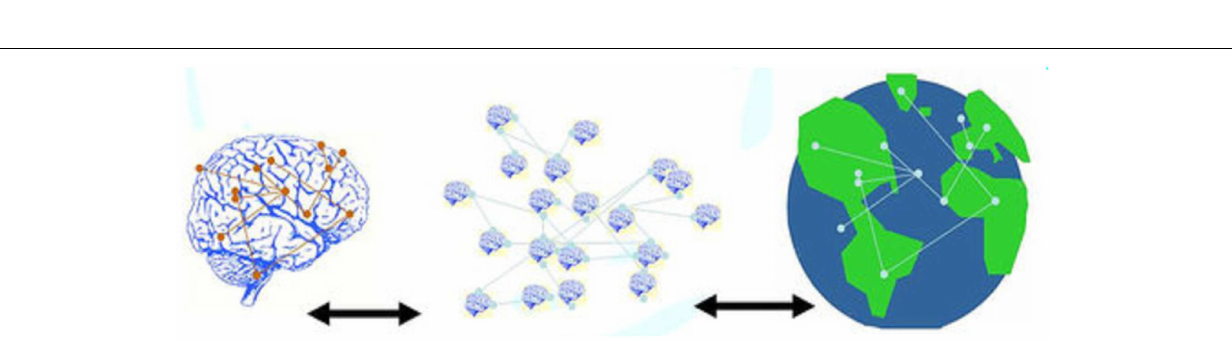
FIGURE 9 | Integrating different spatiotemporal